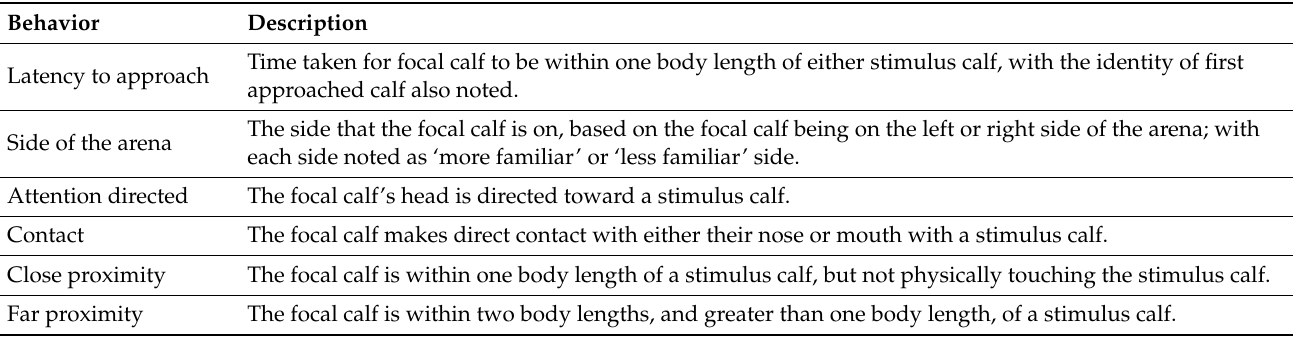
Table 1. Ethogram describing behaviors during the social preference test. Recipient calf (‘more familiar’ or ‘less familiar’ test calf) was noted for all